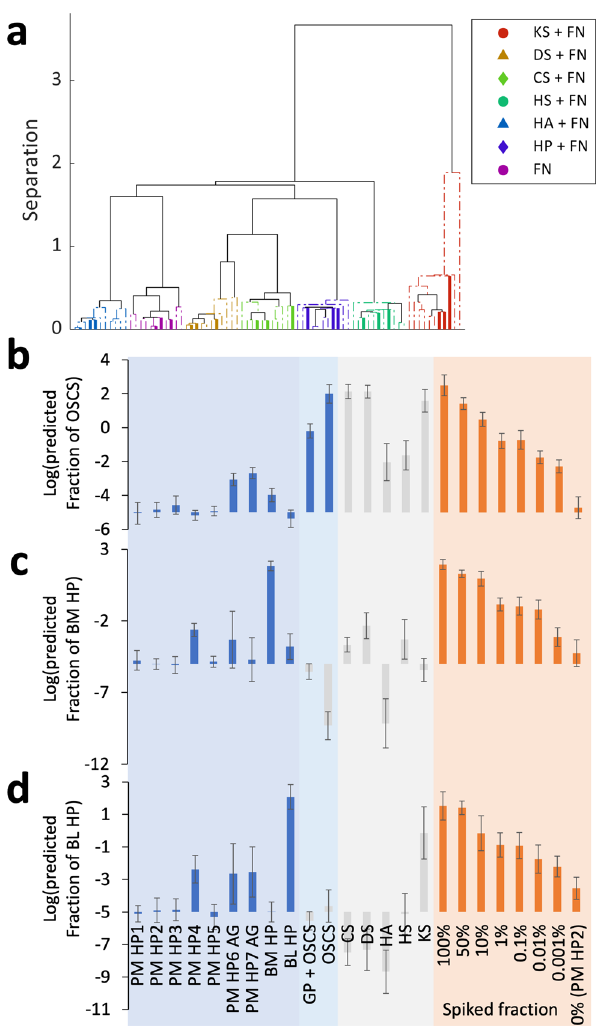
Fig. 3 Summary of multivariate analysis of mixed GAG samples. a PCA of datasets from 6 GAG types mixed with FN. Dendrogram showing hierarchical clustering of GAG samples based upon the scores for PCs 1 and 2 (Supplementary Fig. 10). Training samples are shown as a dashed line and test samples are shown as a solid line. Lines have been coloured to match the sample identity. Legend of sample identity shown with fi gure. b – d Predicted values for the heparin/OSCS samples measured as a part of the 16 GAGs ( ), unrelated GAG types ( ) and heparin (HP) PM spiked with b OSCS, c HP BM and d HP BL ( ) using the corresponding PLS models. Error bars show ± 1 standard deviation unit, n =